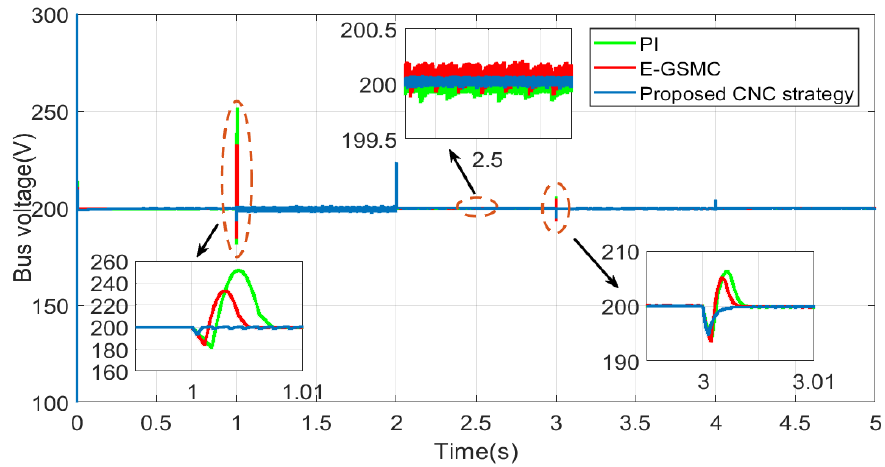
Figure 9. The robust tracking curve of the bus voltage. Table 2. The time costs of three strategies .